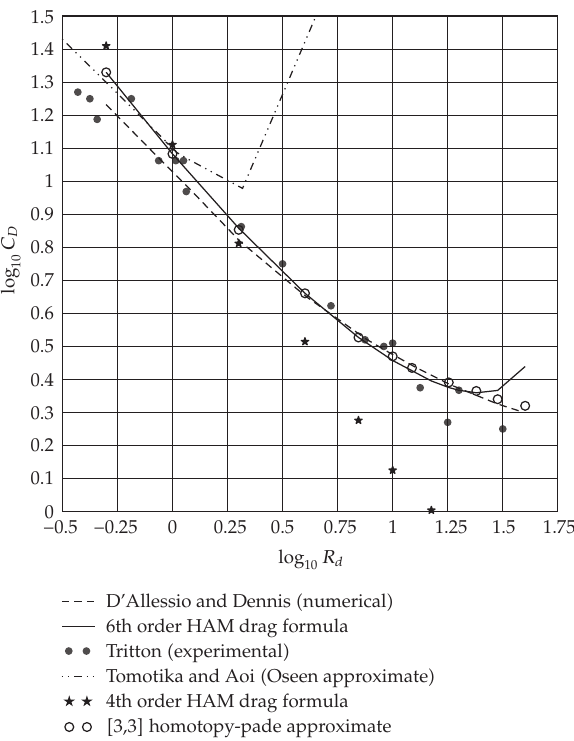
Figure 1: Comparison with previous theoretical and experimental